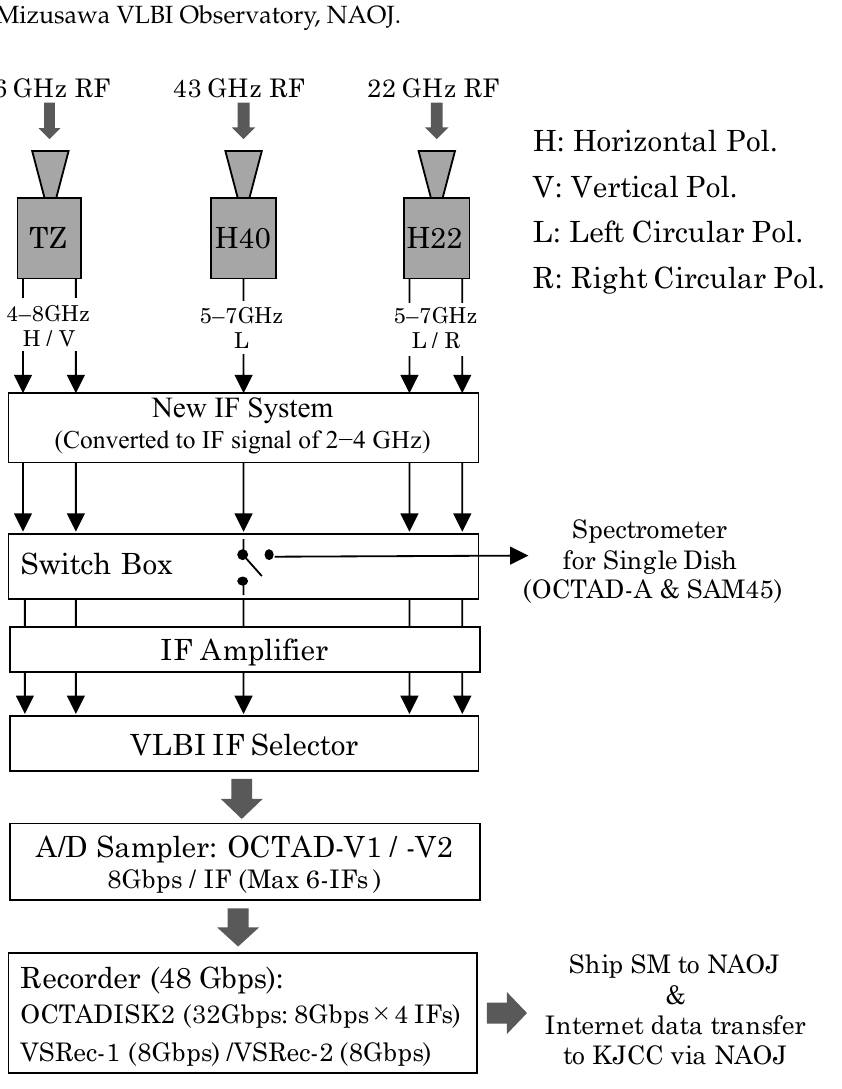
Figure 9. Schematic diagram of the HINOTORI VLBI data acquisition system (HINOTORI DAS). The analog-to-digital (A/D) sampler consists of two OCTAD systems. Because each OCTAD allows 24-Gbps sampling (=8 Gbps/IF × 3 inputs) to be conducted, HINOTORI DAS has the ability to sample up to 48 Gbps (=8 Gbps/IF × 6 inputs or 2 GHz bandwidth/IF × 6 inputs). The recording system consists of OCTADISK2 and two units of VSREC. Because OCTADISK2 allows for recording of up to 32 Gbps (=8 Gbps × 4 inputs), and each